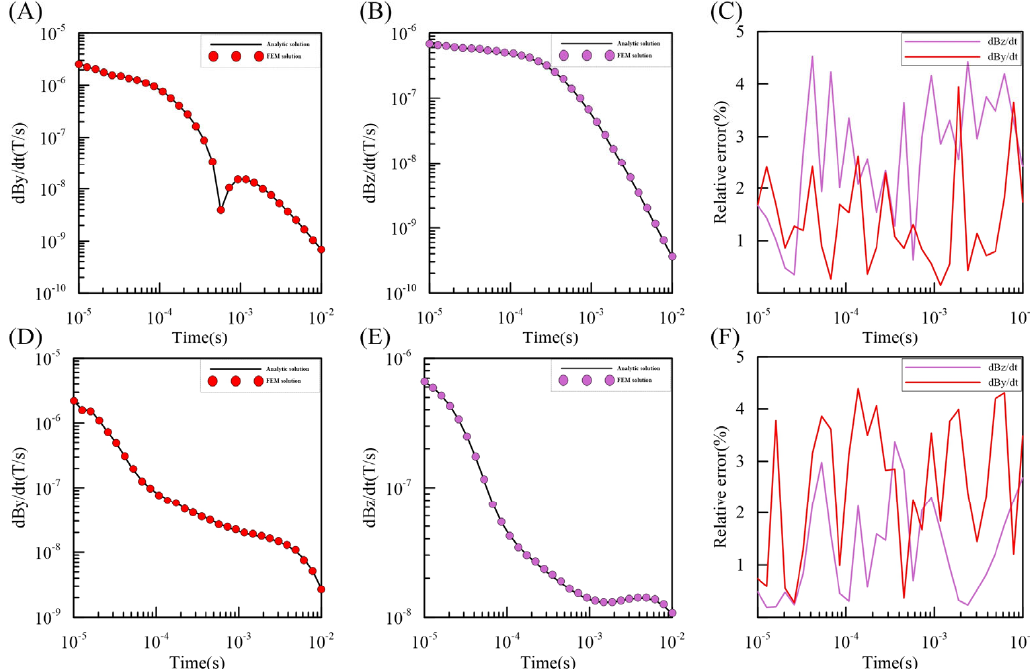
Figure 1. Accuracy verification for the homogeneous and three-layer model. ( A – C ) are the dBy/dt, dBz/dt and relative error for the uniform half-space model; ( D – F ) are the dBy/dt, dBz/dt and relative error for the layered earth model.